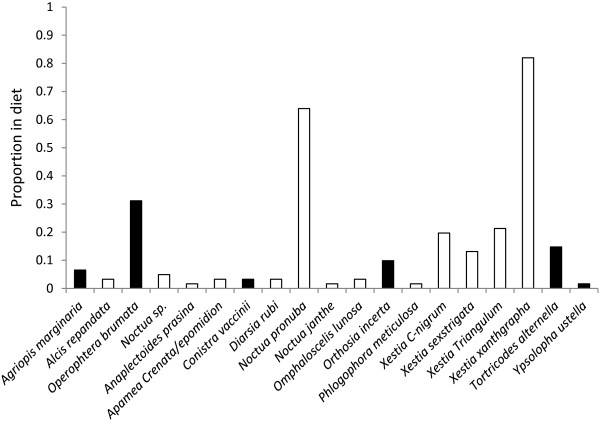
The proportion of Lepidoptera (%F) by species in the winter diet of M. nattereri from DNA analysis of faecal pellets collected from within Greywell Tunnel in December-March 2009–10 and 2010–11 combined. Open bars indicate species predicted to overwinter as larvae and black bars indicate those species that overwinter as adults [44,45].